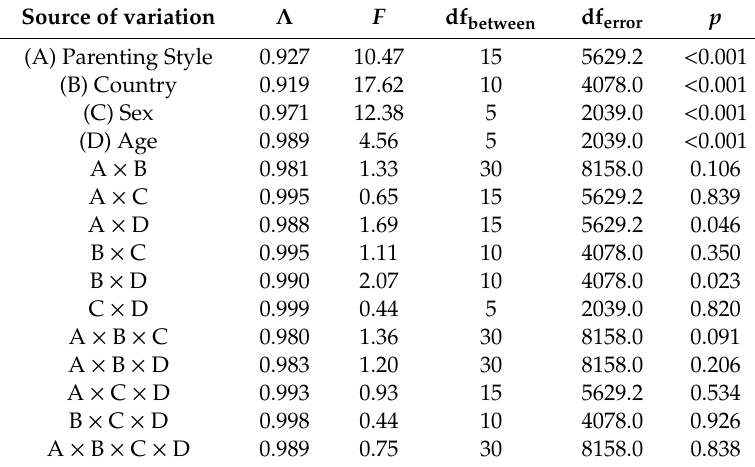
Table 5. MANOVA Factorial (4 a × 2 b × 2 c × 2 d ) for value